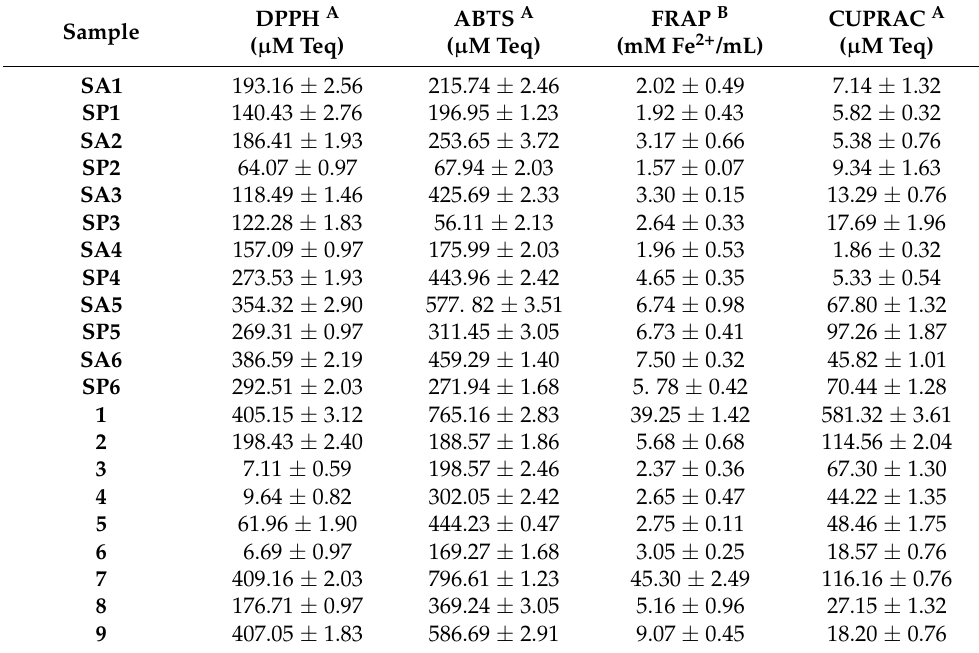
Table 4. Antioxidant activities of SP1 – SP6 , SA1 – SA6 , and compounds 1 – 9 . Sample